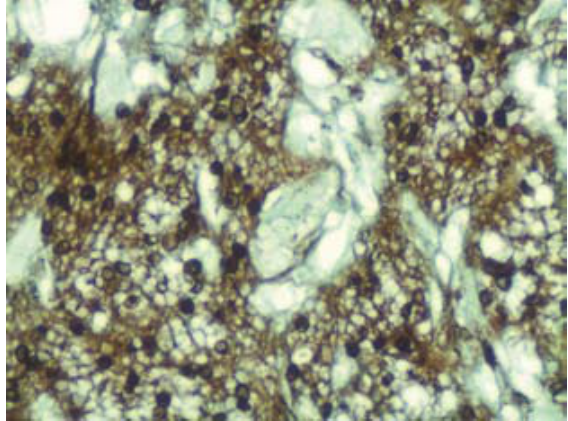
Fig. 1. Grocott-Gomori methenamine-silver stain showing Pneumocystis cysts of variable shape and size (40 ×